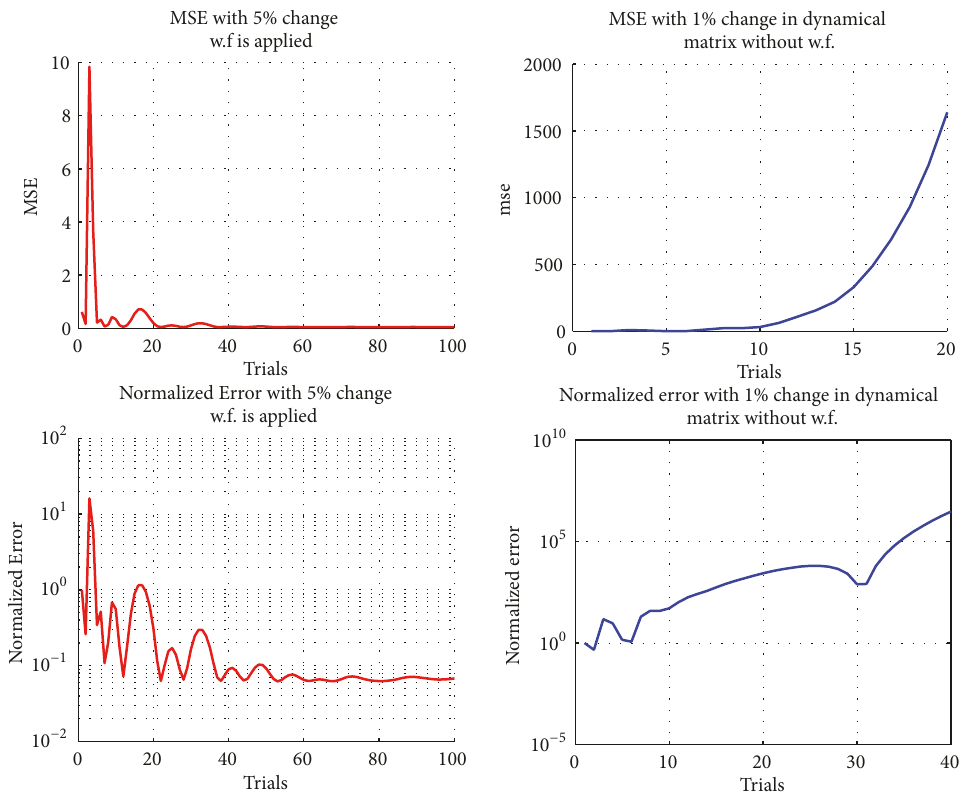
Figure 7: Mean squared error and the normalized error for the NMP output with and without the presence of w.f. Output with matrix (A) changed to: